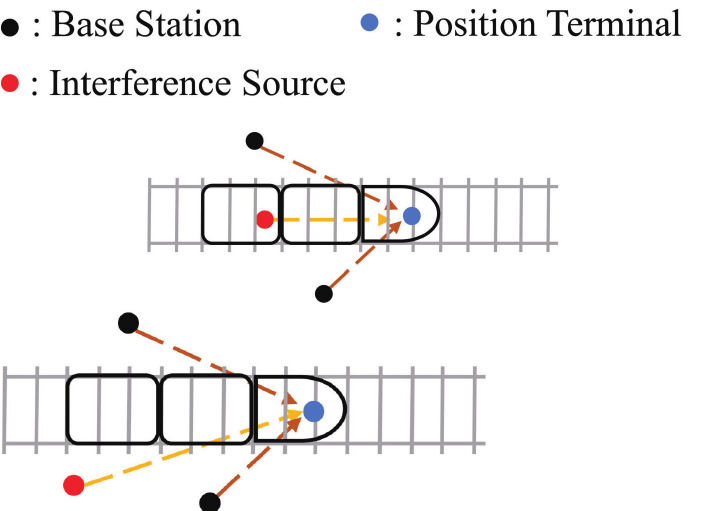
Figure 2. Two modes of interference. ( a ) The interfering signal source is stationary relative to the train positioning terminal; ( b ) The interfering signal source moves relative to the train positioning